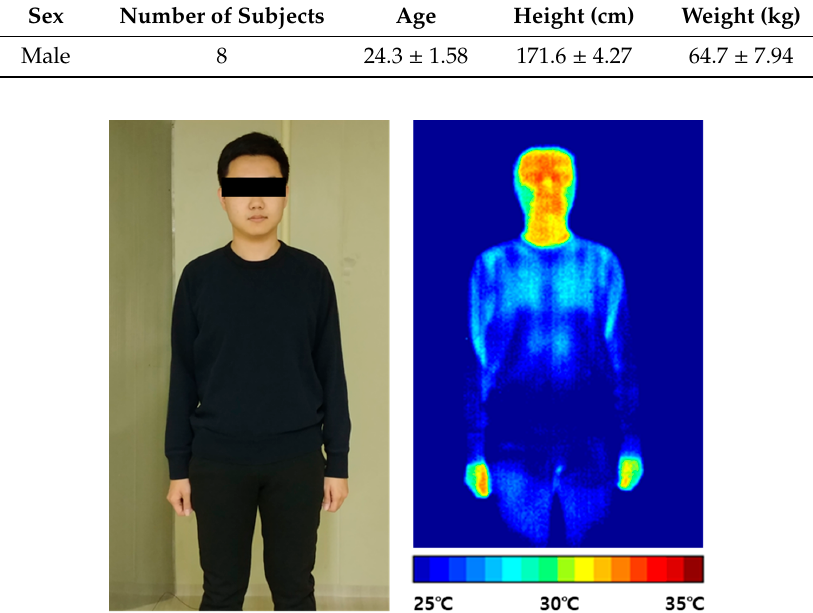
Table 2. Information regarding subjects (mean ± standard deviation).